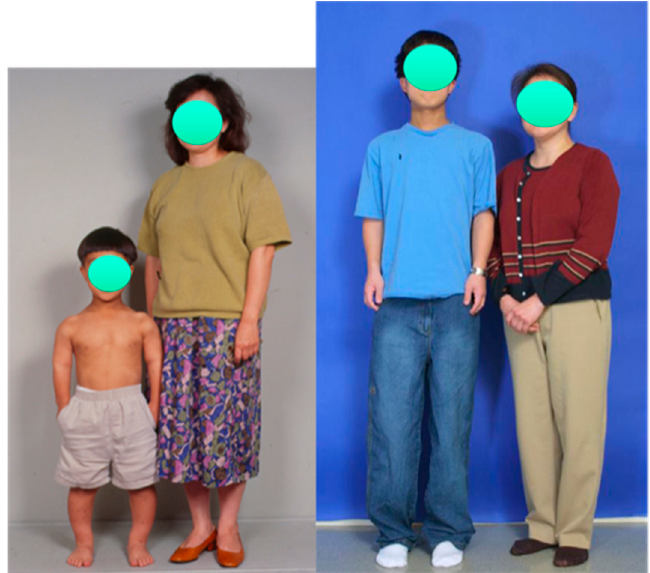
Figure 2. Photograph of male patient with achondroplasia standing beside his mother at age 10 ( left ) and age 16 ( right ). His height increased from 3 ′ 9 ″ (114 cm) before lengthening to 5 ′ 5.5 ″ (165 cm) after three 4-segment lower-limb juvenile-onset lengthenings totaling 15.75 ″ (40 cm). He also had 12 cm lengthening of his humeri.